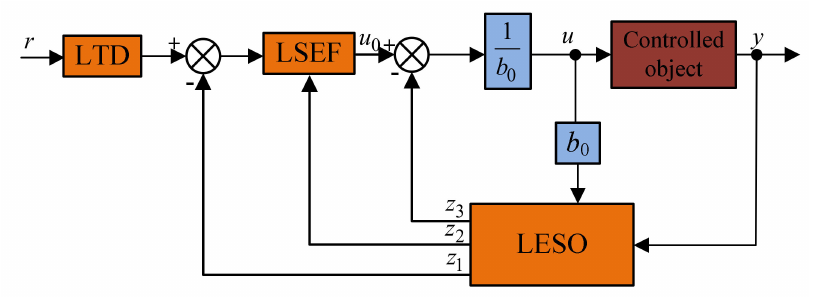
Figure 5. Structure diagram of